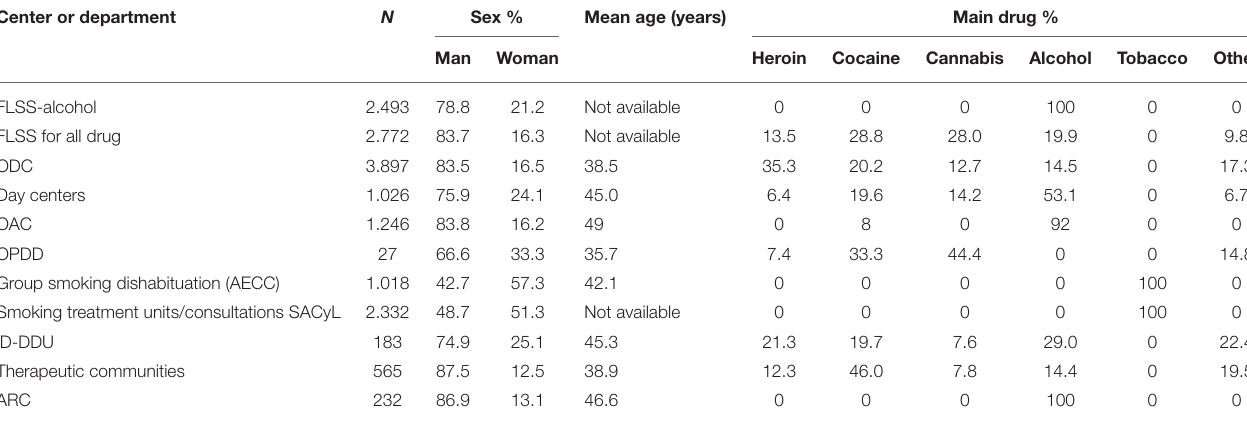
ID-DDU 183 Therapeutic